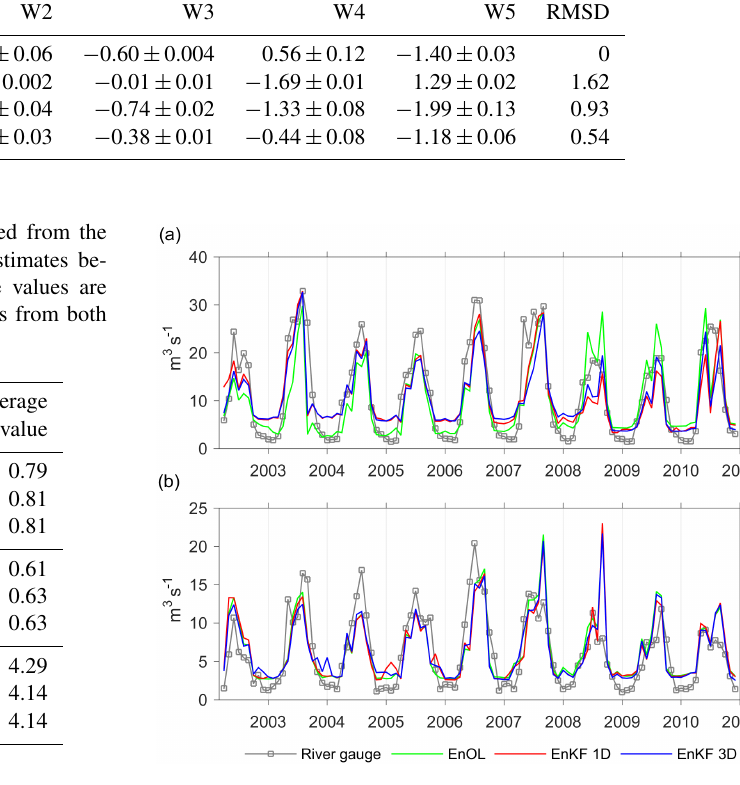
Figure 13. Monthly streamflow estimates from the in situ river gauge measurements, as well as EnOL, EnKF 1D, and EnKF 3D results, between April 2002 and December 2010 at two river gauge locations, G1 (a) and G2 (b)